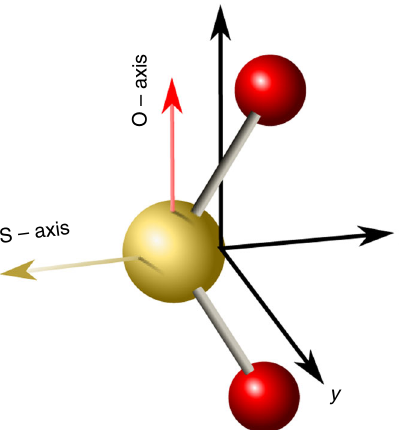
Fig. 7 The SO 2 molecule. Axes x , y and z are the principal axes of the molecule. All atoms lie in xz plane, oxygen is colored red, sulfur is yellow